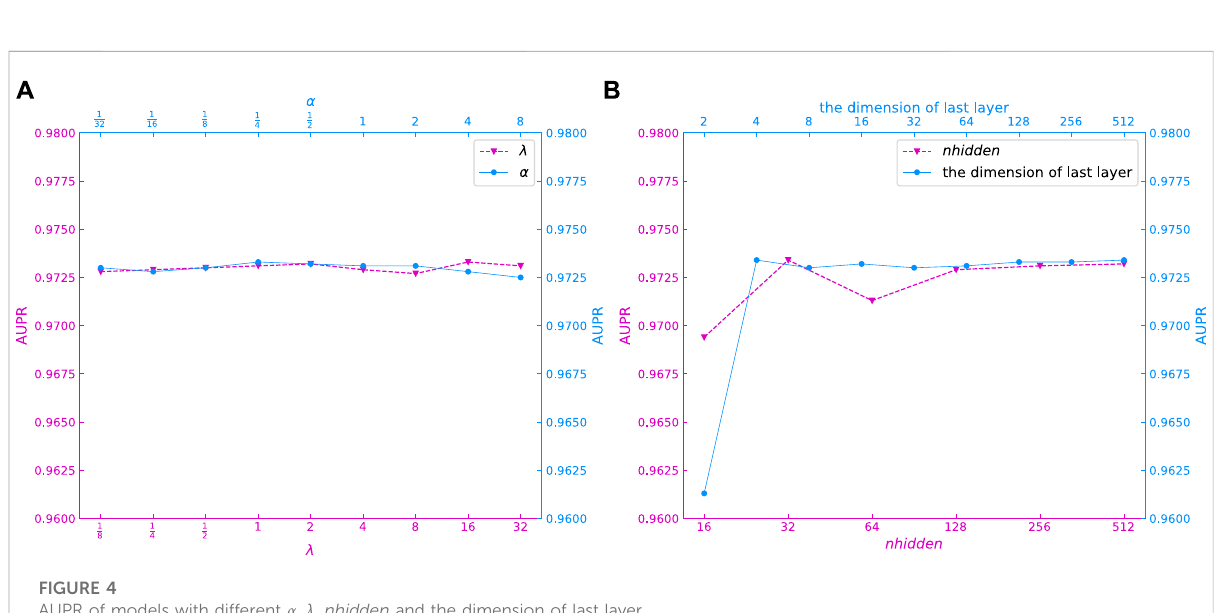
FIGURE 4 AUPR of models with different α , λ , nhidden and the dimension of last